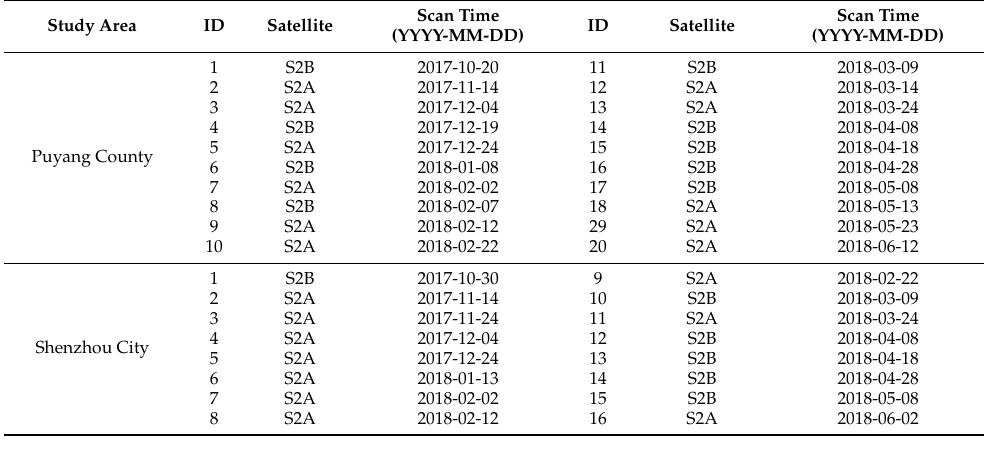
Table 1. Sentinel-2 images used in this study.